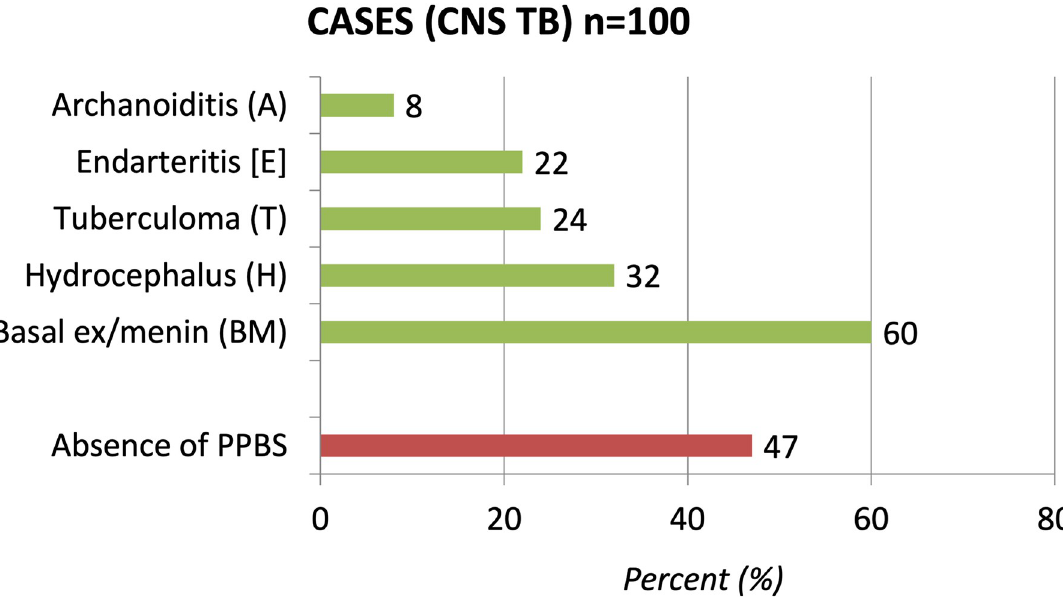
Fig 3. Prevalence of various radiological features of CNS TB cases. (BM)Basal exudates or Meningeal enhancement,(A)Arachnoiditis, (E)Endarteritis,(T) Tuberculoma,(H) Hydrocephalus and absence of posterior pituitary bright spot(PPBS).